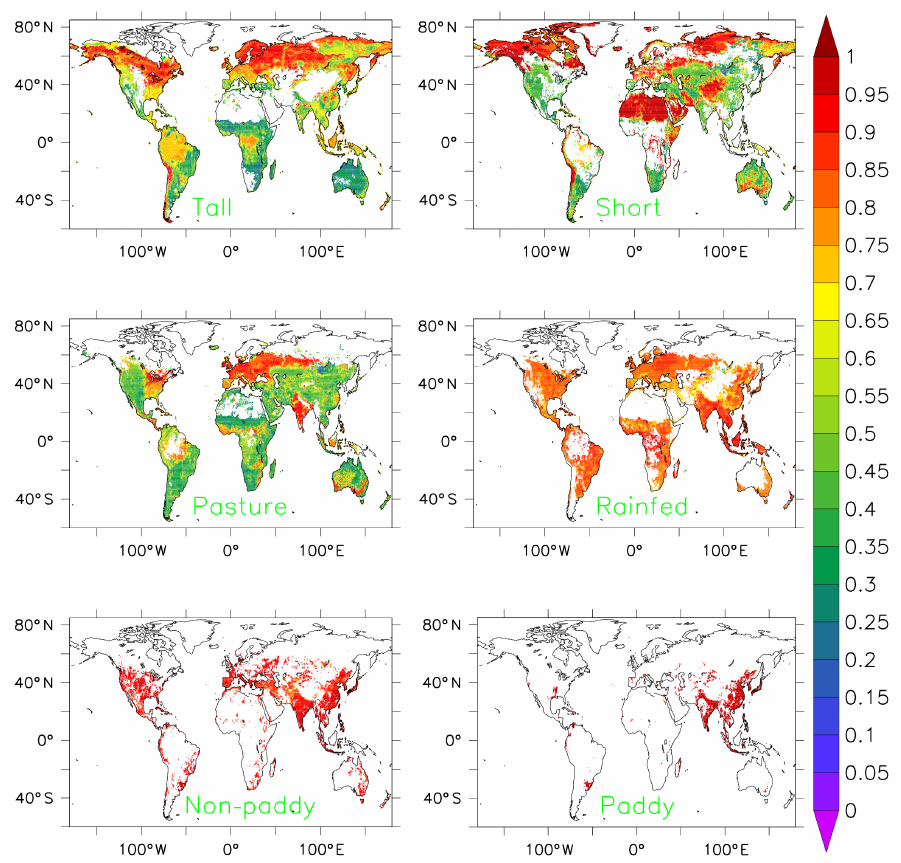
Figure A3. Root fraction in soil layer 1 (upper soil layer, reaching 0.13 to 0.3m depth) in LC2000 per land cover type, used to compute land-cover-specific transpiration. A fraction of 1 indicates that all roots are in the upper layer, i.e., no water is taken by the roots from the deeper soil layer. Values are given where a land cover type covers more than 1% of a grid